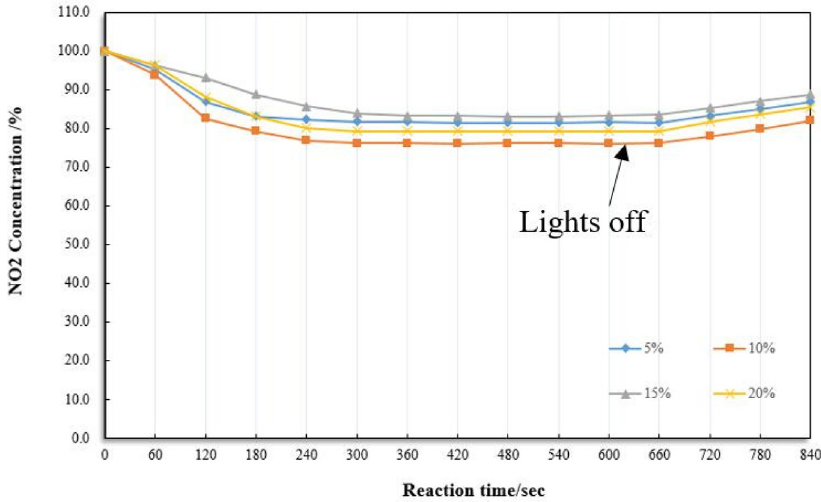
Figure 14. Degradation efficiency under different dosages.